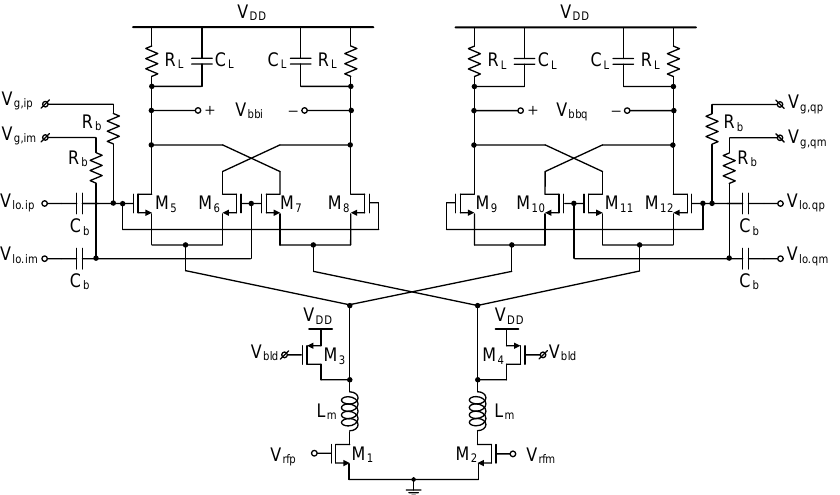
Figure 3. Quadrature down-conversion mixer schematic.